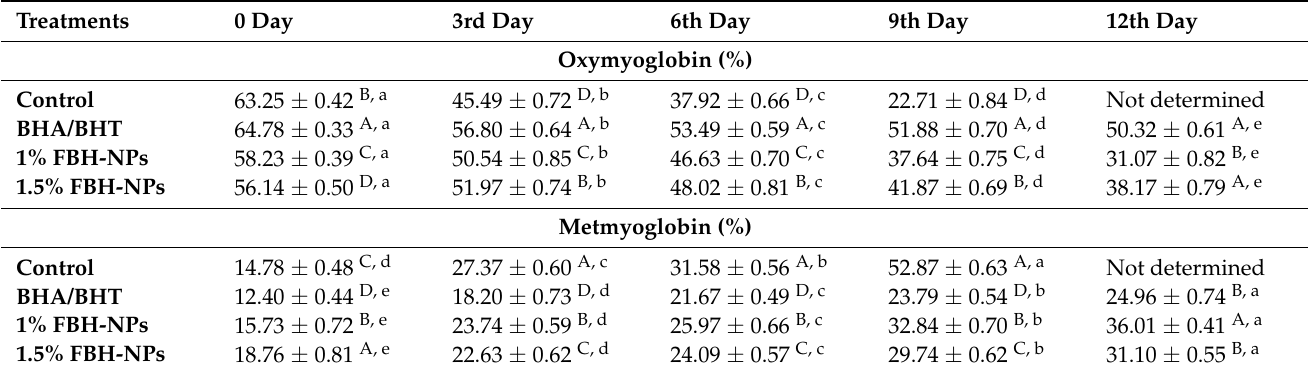
Table 4. Effect of adding FBH-NPs on oxymyoglobin and metmyoglobin content in burgers during refrigerated